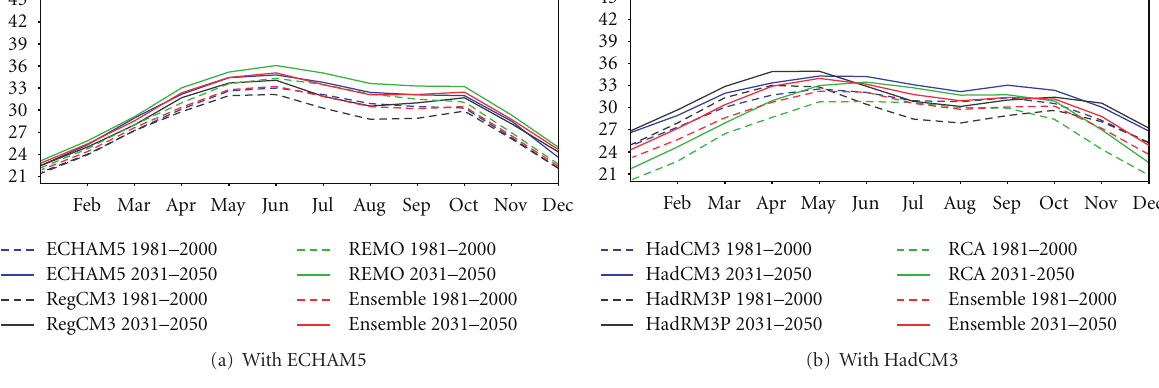
Figure 13: Present-day and future annual cycles of temperature (in ◦ C) over Western Sahel from: GCMs (ECHAM5 and HadCM3), RCMs (RegCM3, REMO, RCA, and HadRM3P), and the ensemble mean of RCMs driven by ECHAM5 and HadRM3P. The present-day is represented by dashed lines and future by solid